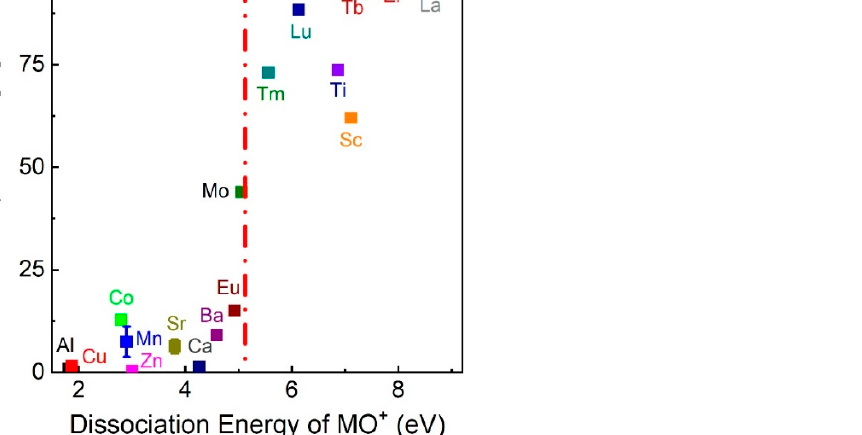
Figure 1. The ratio of MO + /(M + + MO + ) vs. dissociation energy of MO + species as determined at 1.5 × 10 − 1 mbar O 2 . The dashed line represents the dissociation energy of O 2 , E dissoc ( O 2 ) = 5.12 eV [9]. Licensee: Christof W Schneider Order Date: 12 July 2022. Order Number: 5346500707826 Publication: Applied Physics